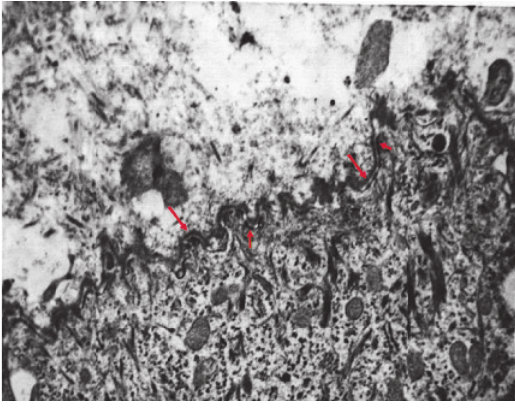
3 weeks after composite skin transplantation using 1:5 mixed keratinocytes, formation of a continuous basement membrane is seen at the dermal-epidermal junction (large arrow), and hemidesmosomes are seen along the junction (small arrow)